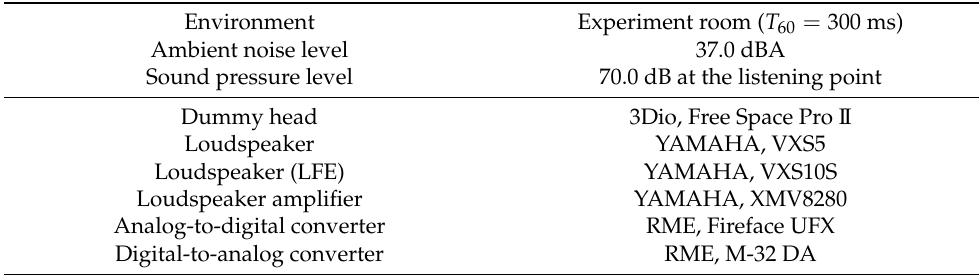
Table 2. Experimental environment and